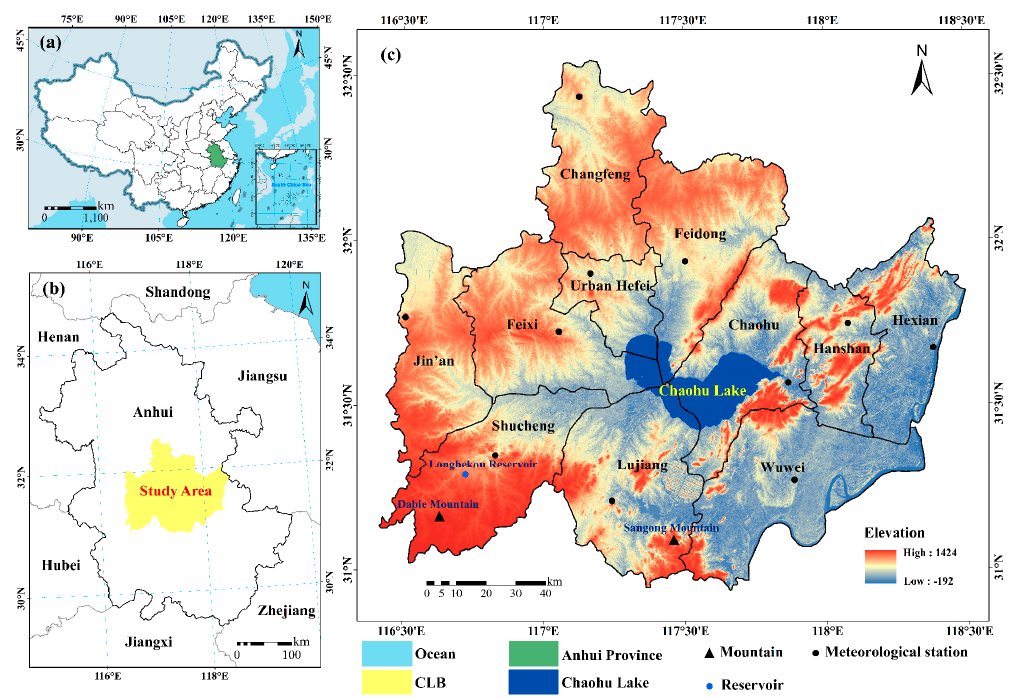
Figure 1. The study area: ( a ) the location of Anhui province in China; ( b ) the location of the Chaohu Lake Basin (CLB) in Anhui province; ( c ) the digital elevation model (DEM) of the CLB.